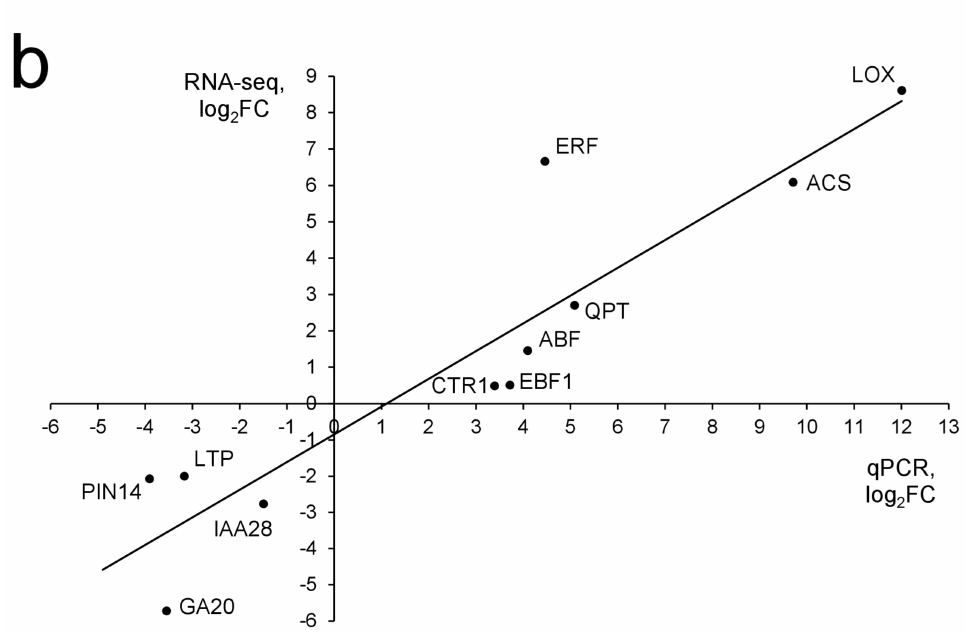
Figure 1. Verification of RNA-Seq data by qPCR. ( a ) Log 2 Fold Changes measured by qPCR (white bars) and RNA-Seq (black bars); ( b ) Correlation of log 2 FC values calculated based on RNA-seq (X-Axis) and qPCR (Y-Axis) data. Pearson’s r = 0.92 and is significant at p <